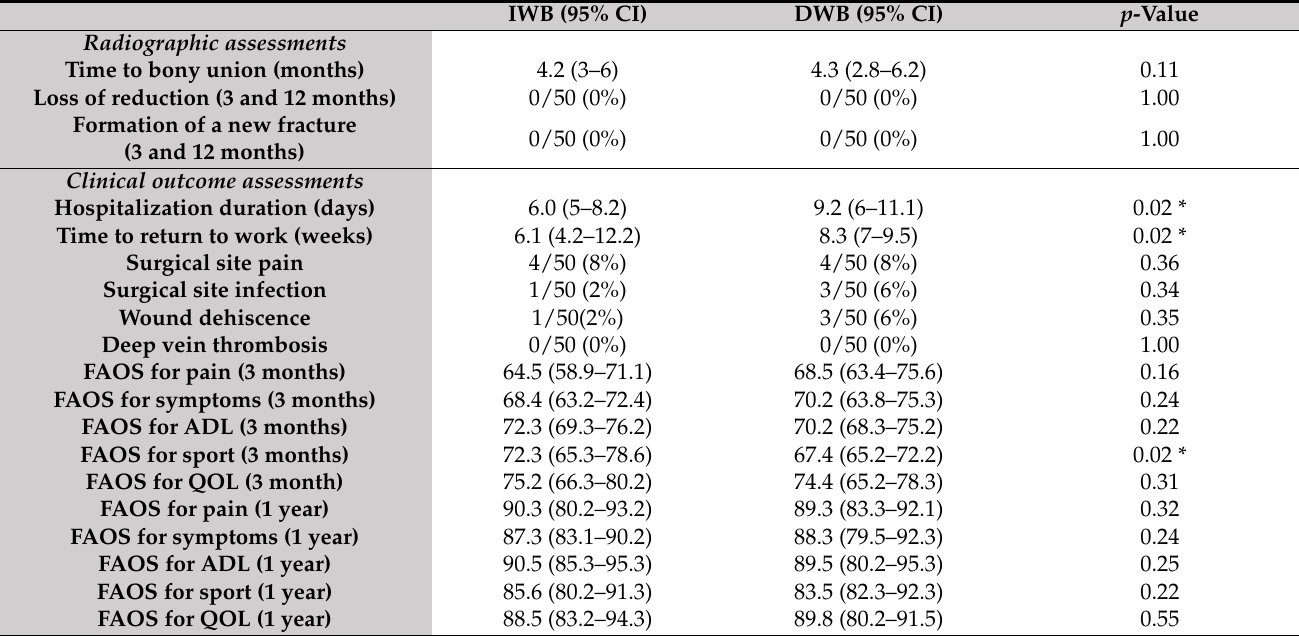
Table 2. Comparison of primary and secondary outcomes between the immediate and delayed weight-bearing